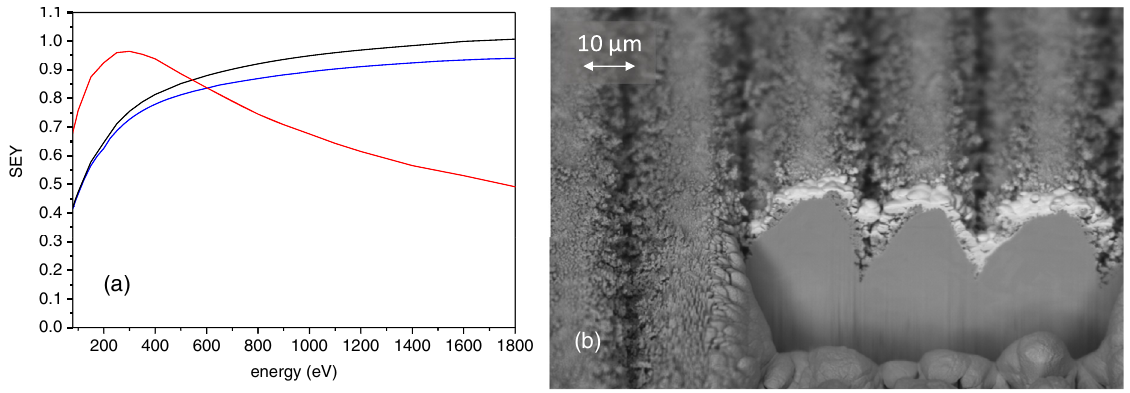
FIG. 3. (a) SEY measurement of LESS witness samples, before (blue line) and after water rinsing (black line), and of a typical a-C- coated Cu sample (red line). (b) SEM image of a cross section of a LESS sample (reproduced from Ref. [20] with STM